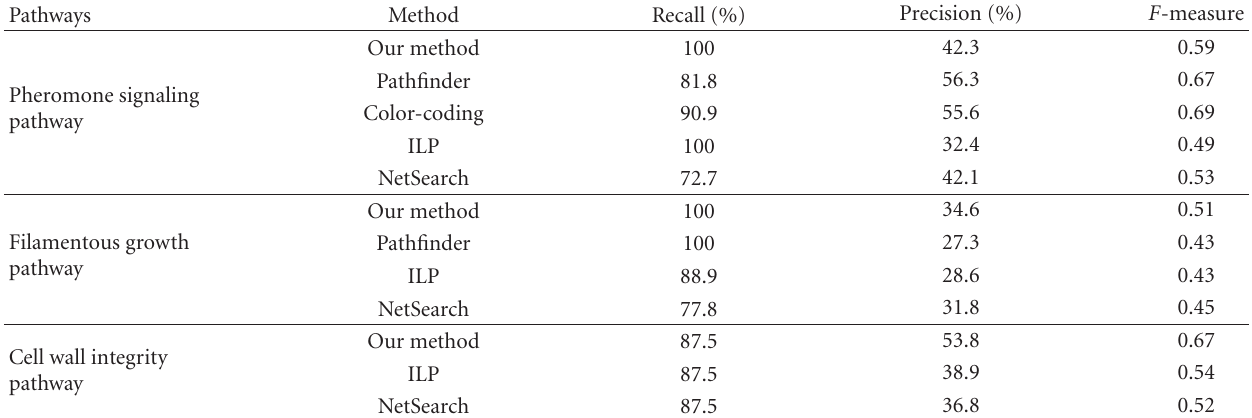
Table 2: Recall and precision of previous and our